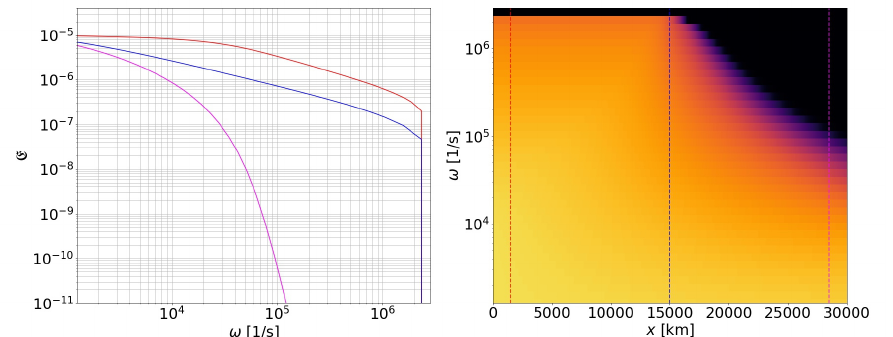
Figure 6. Steady state of the parallel-propagating wave mode of a simulation of a L = 30,000 km coronal loop with equal wave spectral energy density injections at both edges. The anti-parallel- propagating wave information is omitted due to symmetry with the parallel-propagating wave information. The plot on the left contains slices of the wave spectral energy density data at three locations, which are color coded to match to the dashed lines on the contour plots. The normalization value is α = 1 × 10 − 5 .